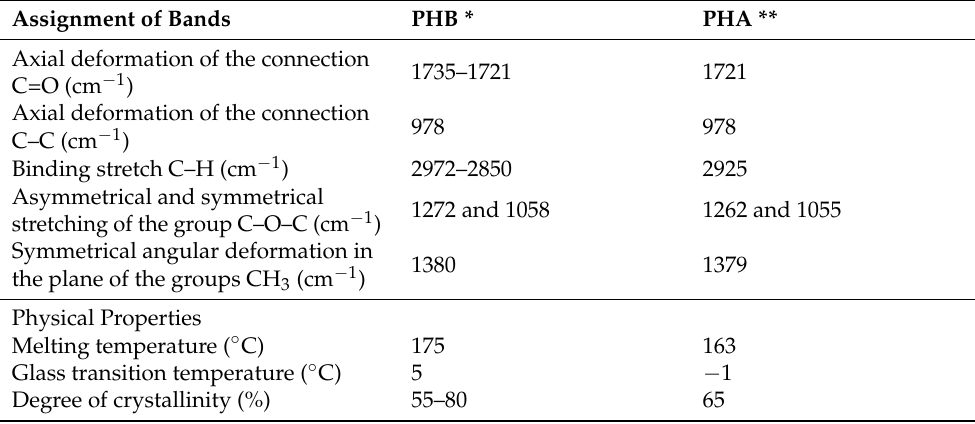
Table 4. Characteristic bands in the infrared spectrum and main physical properties of PHB and PHA obtained in this